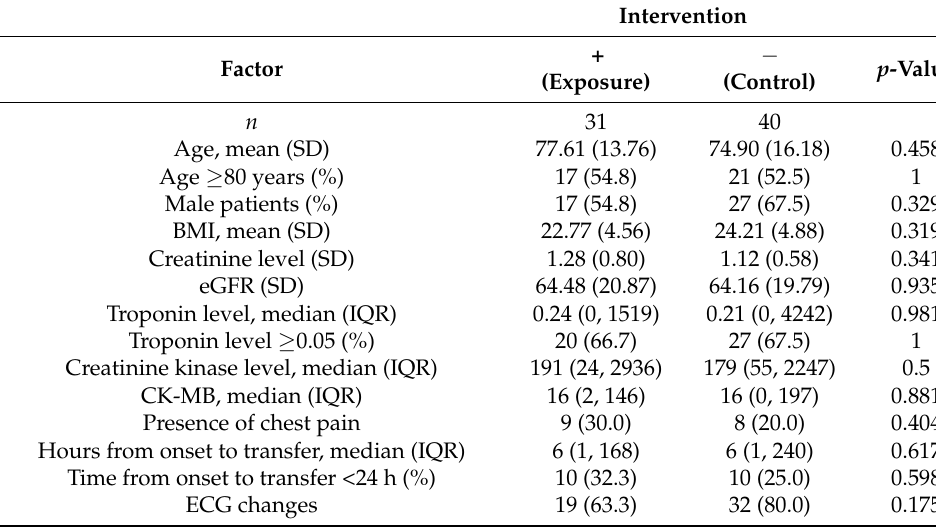
Table 1. Demographic characteristics of the participants.